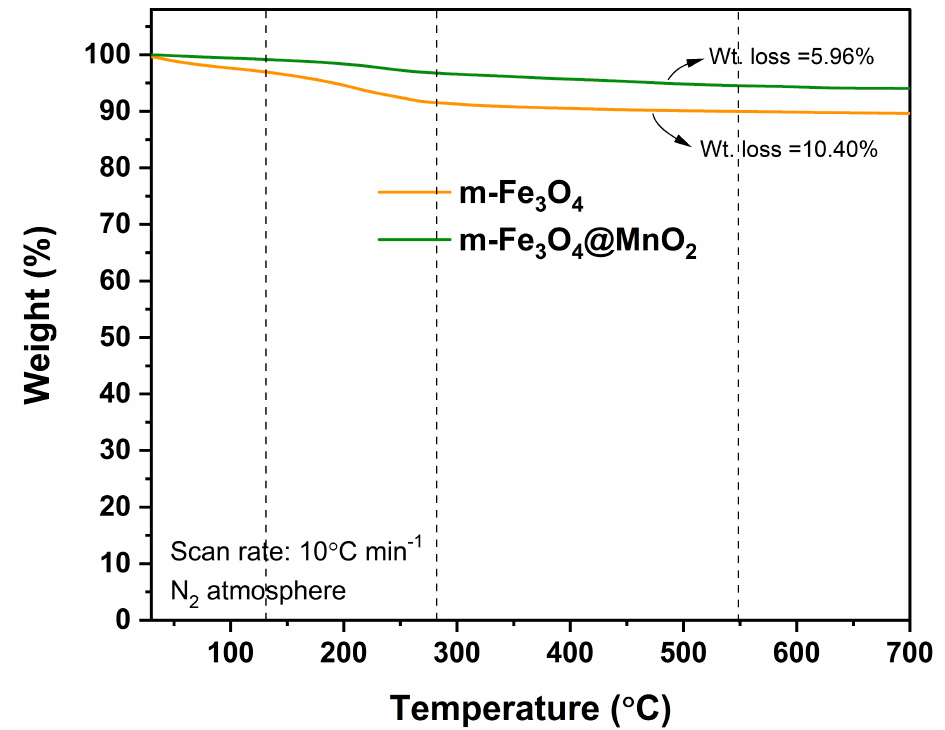
Figure 6. TGA results of m-Fe 3 O 4 and m − Fe 3 O 4 @MnO 2 nanocomposite.